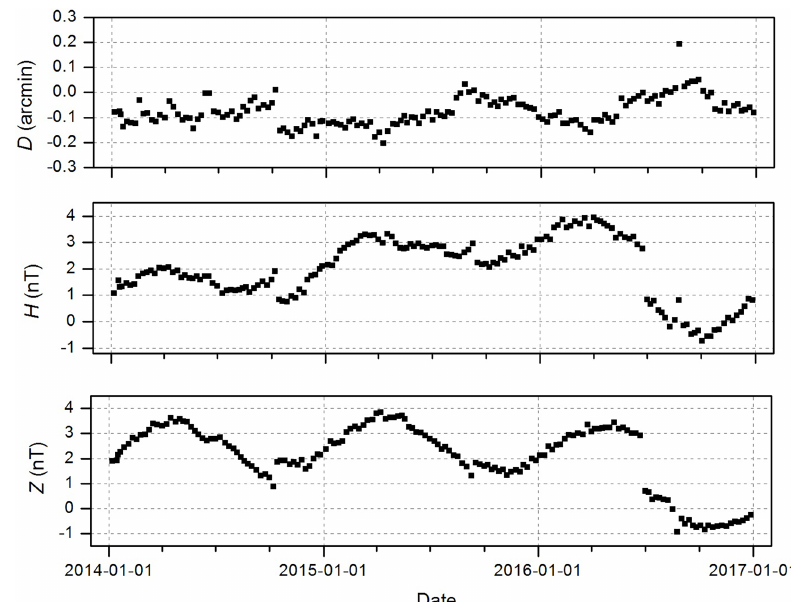
Figure 4. KAK baselines values obtained from 2014 to 2016. The data of the KAK observatory were provided by the Kakioka Magnetic Observatory, Japan Meteorological Agency.